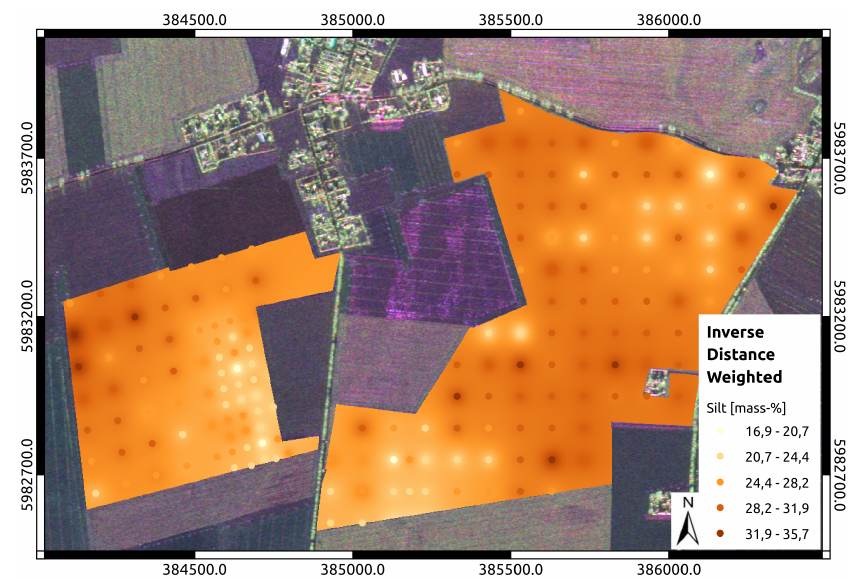
Figure 15. Spatial interpolated soil map for the texture class silt based on the IDW approach. Circles display the sample locations and colors are scaled in the same color as background silt map.